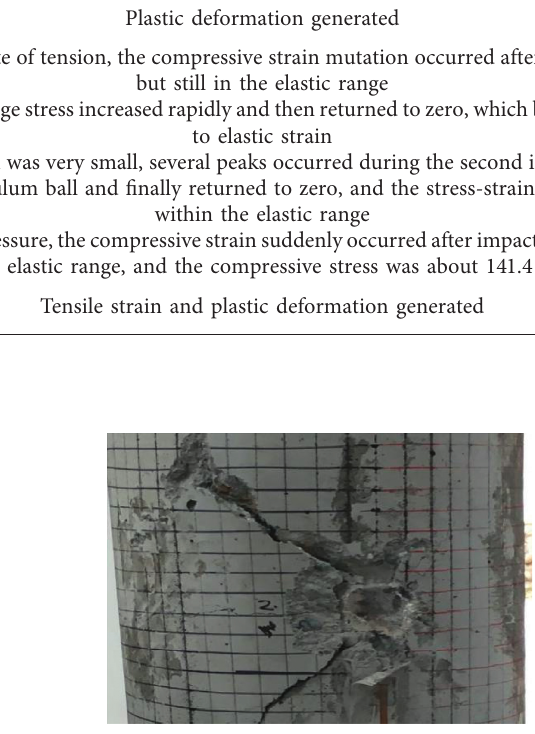
Figure 24: Damage condition of S